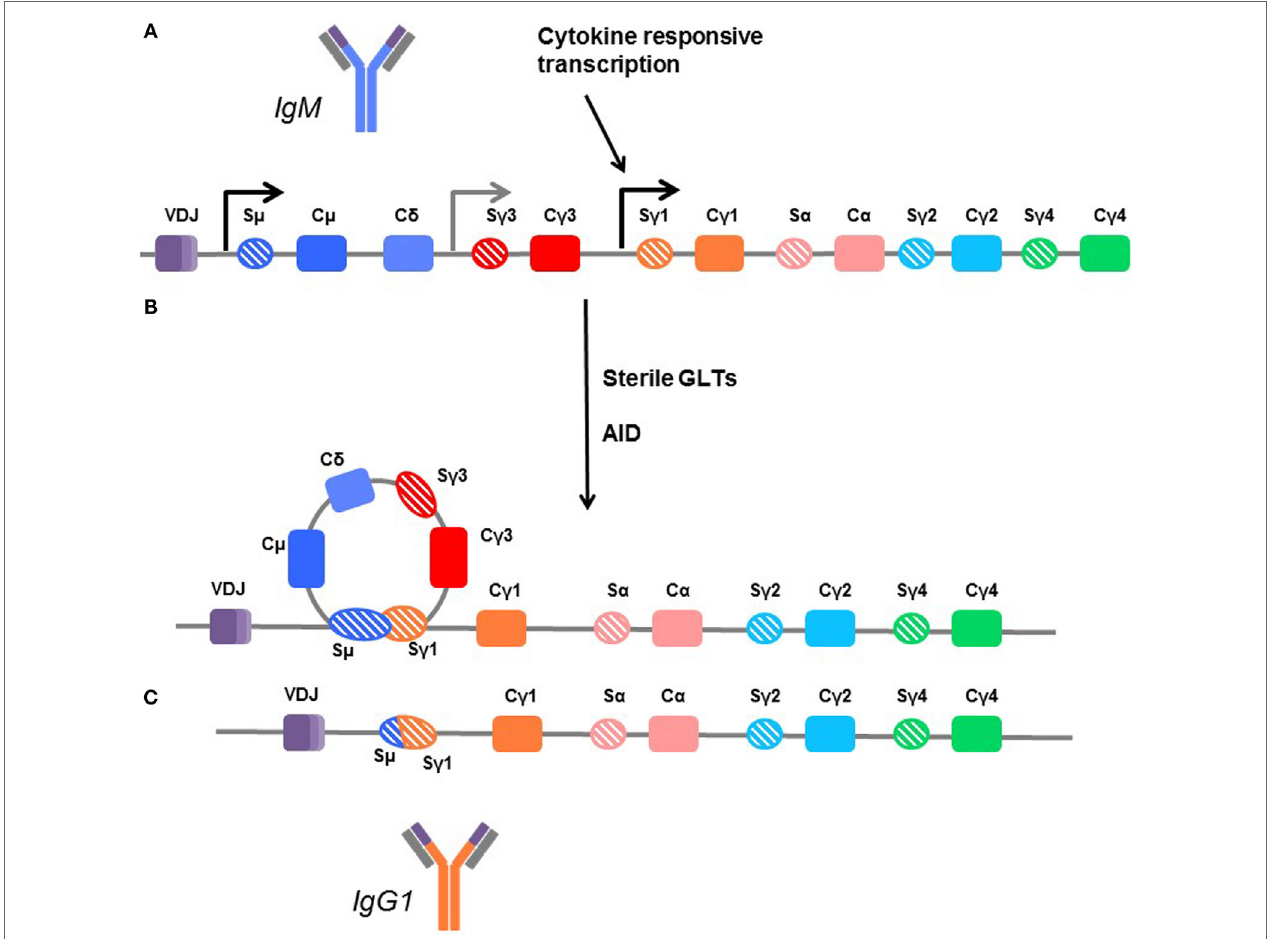
FiGURe 4 | Mechanisms of class switching . (A) In unswitched human B cells, the germline arrangement of heavy chain immunoglobulin genes is ordered by the variable region (VDJ) followed by the constant regions for IgM (C μ ), IgD (C δ ), IgG3 (C γ 3), IgG1 (C γ 1), IgA1 (C α ), IgG2 (C γ 2), and IgG4 ( γ 4). Each is flanked by a switch region (e.g., S γ 3). These regions are sites of transcription initiation and produce sterile germline transcripts (GLTs). (B) Transcription from the flanking switch regions is thought to make the DNA accessible to enzymes, such as activation-induced cytidine deaminase (AID), which facilitates recombination between switch regions, looping out the interior constant region genes. (C) In this example, the B cell is switching directly from IgM (dark blue) to IgG1, and the C μ , C δ , and C γ 3 genes are removed so that the variable region can be directly fused with the C γ 1 region to form the IgG1 molecule (orange). Thus, B cells which are isotype switched can only further isotype switch the remaining subclasses downstream. C γ 4 is